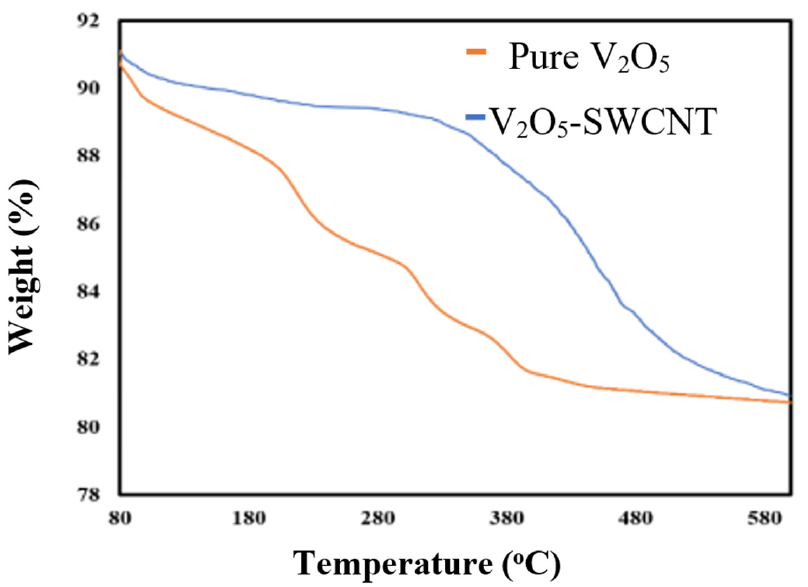
Figure 6. TGA graphs of pristine V 2 O 5 and V 2 O 5 -SWCNT composites showing structural change and thermal stability during the annealing process.